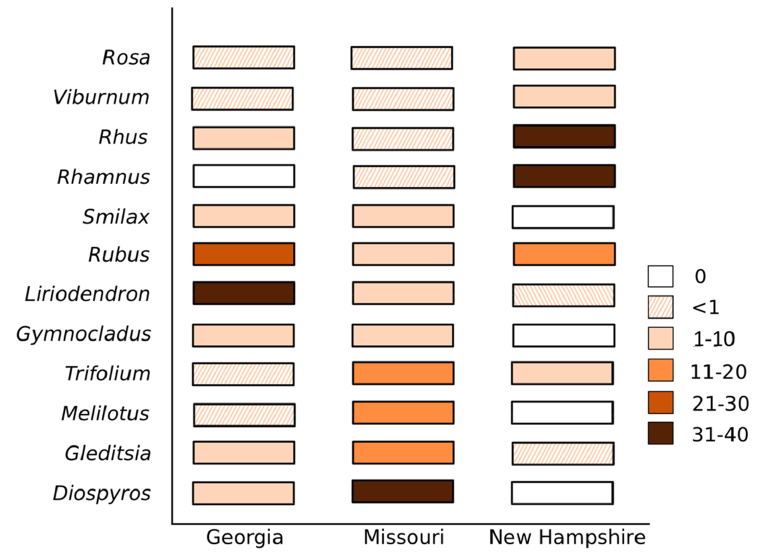
Figure 4. The percentage of rbcl reads found across the top 12 plant genera in brood provisions from each site. The most abundant plant genera varied between each state.